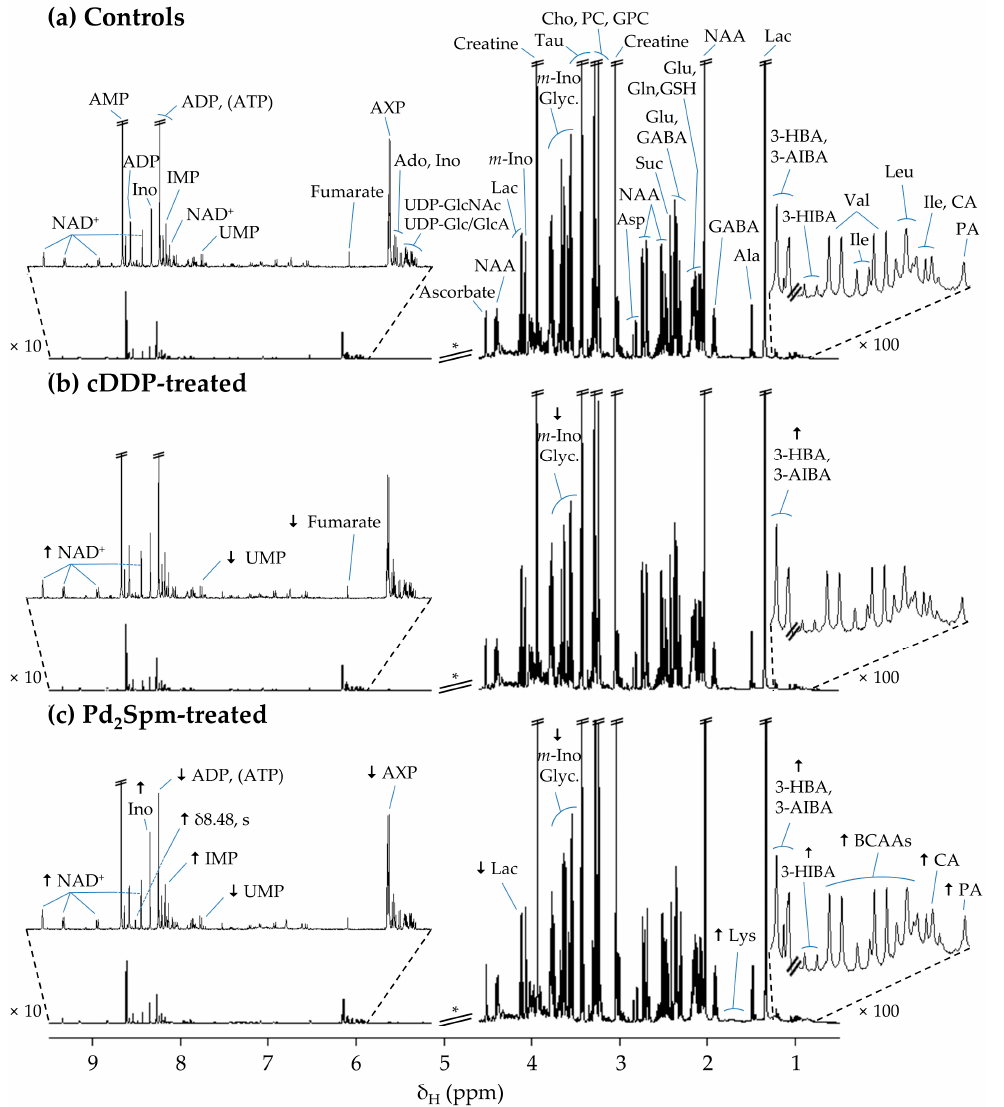
Figure 1. Average 500 MHz 1 H Nuclear Magnetic Resonance (NMR) spectra of an aqueous profile of brain from a cell-derived xenograft (CDX) mouse model of TNBC exposed to ( a ) vehicle solution (phosphate-buffer saline, PBS), ( b ) cDDP (2 mg/kg/day), and ( c ) Pd 2 Spm (5 mg/kg/day). * Cut-off of water suppression region ( δ 4.6–5.1 ppm), not considered in the multivariate analysis. The arrows identify metabolic variations found with visual inspection of spectra from each treated group compared to controls ( ↑ , increase; ↓ , decrease). Abbreviations: 3-letter code for amino acids; 3-AIBA, 3-aminoisobutyrate; 3-HBA, 3-hydroxybutyrate; 3-HIBA, 3-hydroxyisobutyrate; Ado, adenosine;